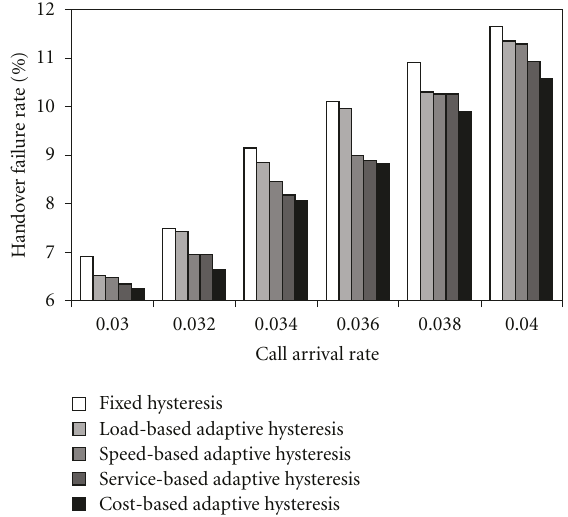
Figure 5: HFR by the five hysteresis schemes under a variety of call arrival